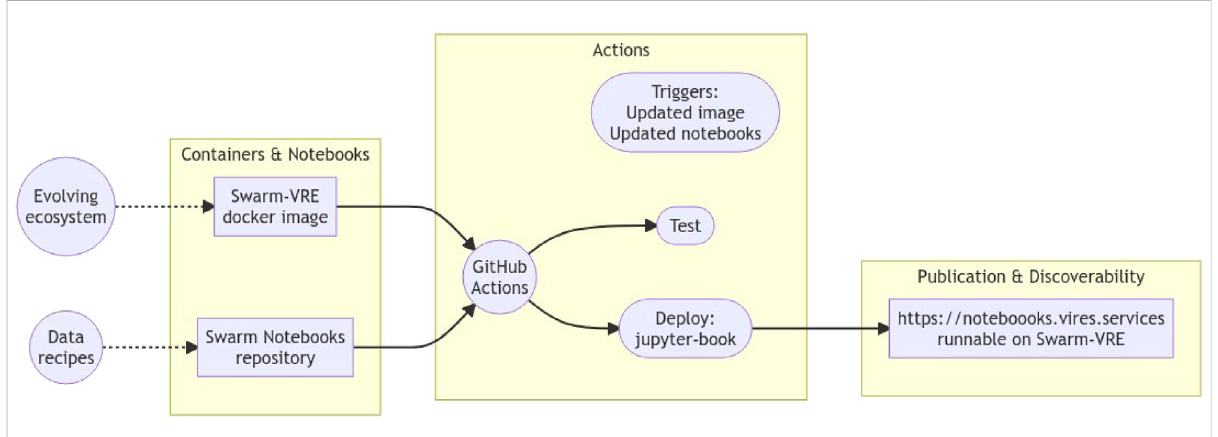
FIGURE 6 Architecture formaintainingnotebooks.Containersprovideareliableexecutionenvironmentbothfortestingthenotebooks automaticallyand for end users interacting with notebooks on the JupyterHub. Notebooks are stored in a versioned repository to which multiple people can contribute,whicharethentestedonGitHubActionsandcompiledintoanHTMLrepresentationusingJupyterBook(verifyingthattheyexecutefrom top to bottom and allowing a human to manually review the output). The Jupyter Book deployment is the main way in which people can discover and read the notebooks, linked to the JupyterHub in order to interact with